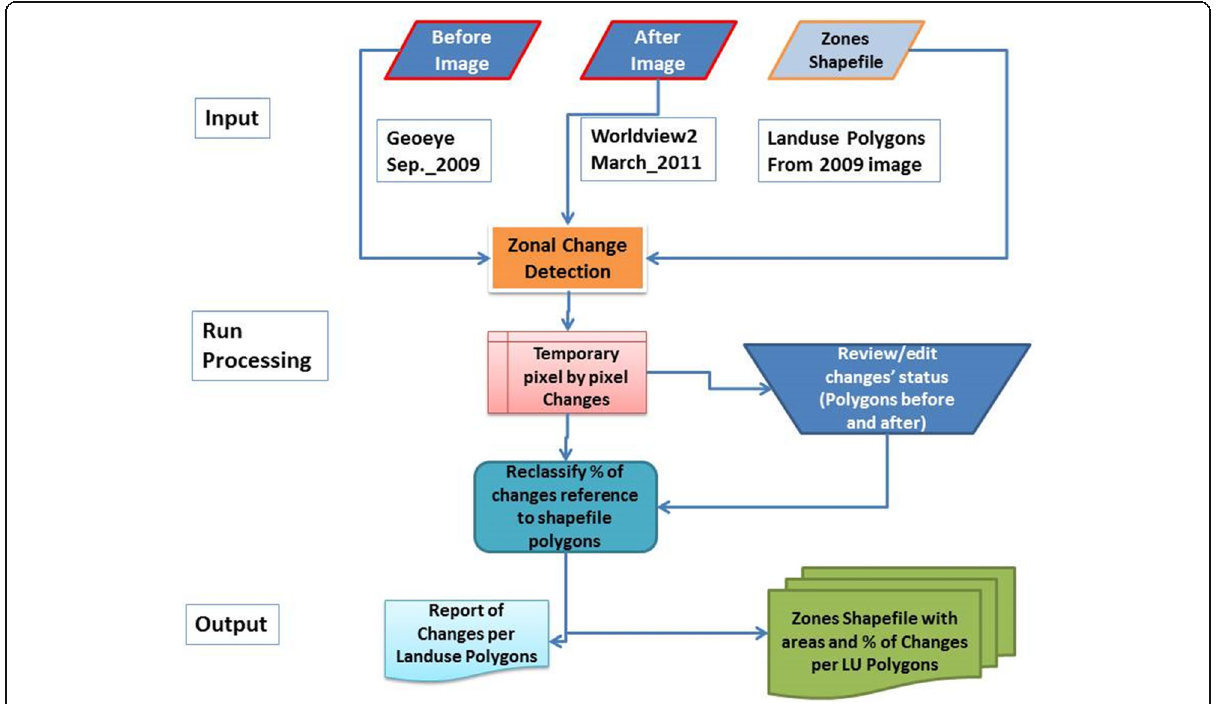
Fig. 3 Logical framework of the zonal change detection model and processing steps